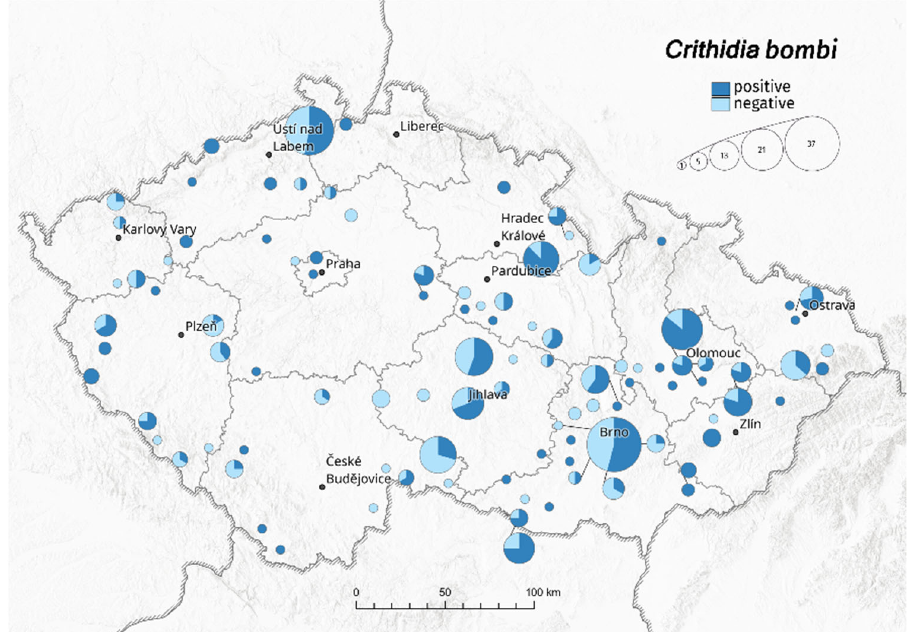
Figure 1. Sampling locations and the ratio of Crithidia bombi infection to uninfected bumblebees in the Czech Republic. The circles reflect the number of samples in sampling locations.